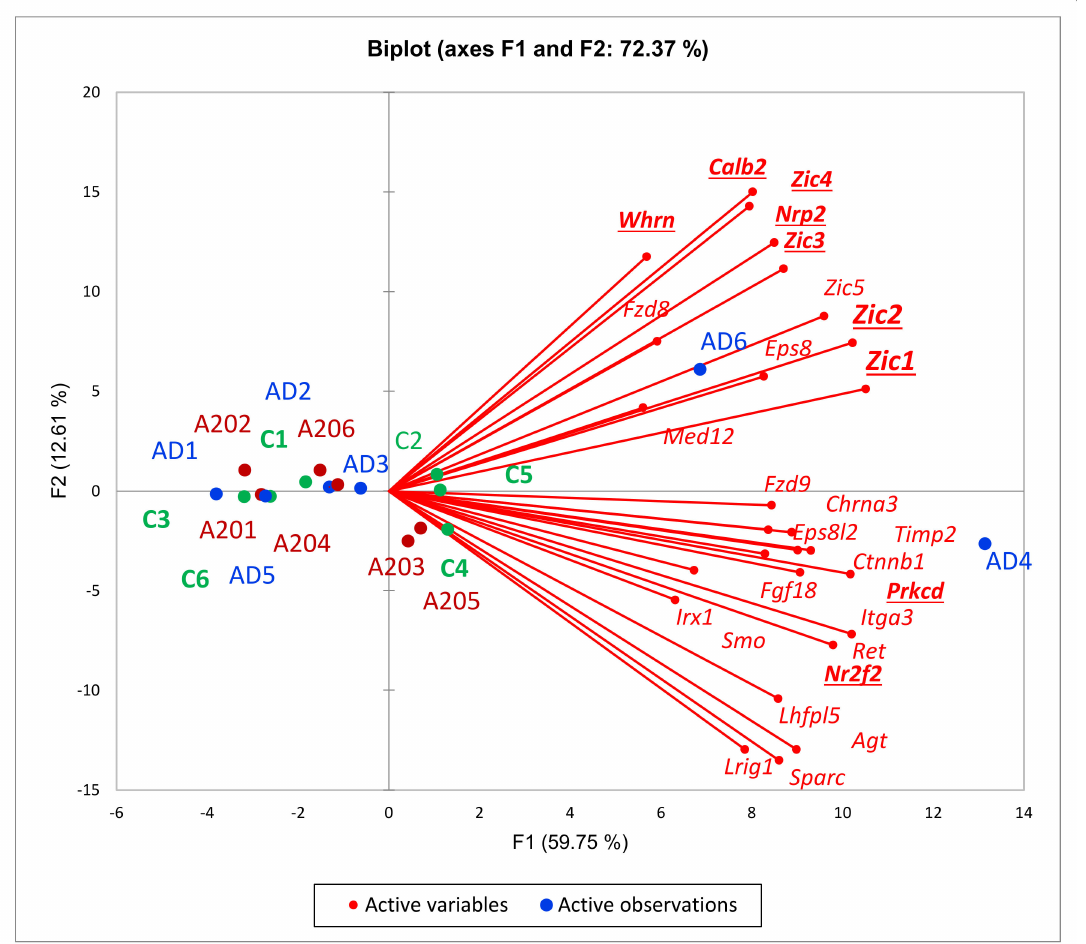
Figure 8. PCA plot of 27 genes from Figure 7 gene network of AD-specific Wnt -associated ( Ctnnb1 , Prkcd , Fzd8 , Fzd9 ; [31]) TF program; see also Figures 2 and 3. Bold underlined gene names indicate 9 DEGs within this